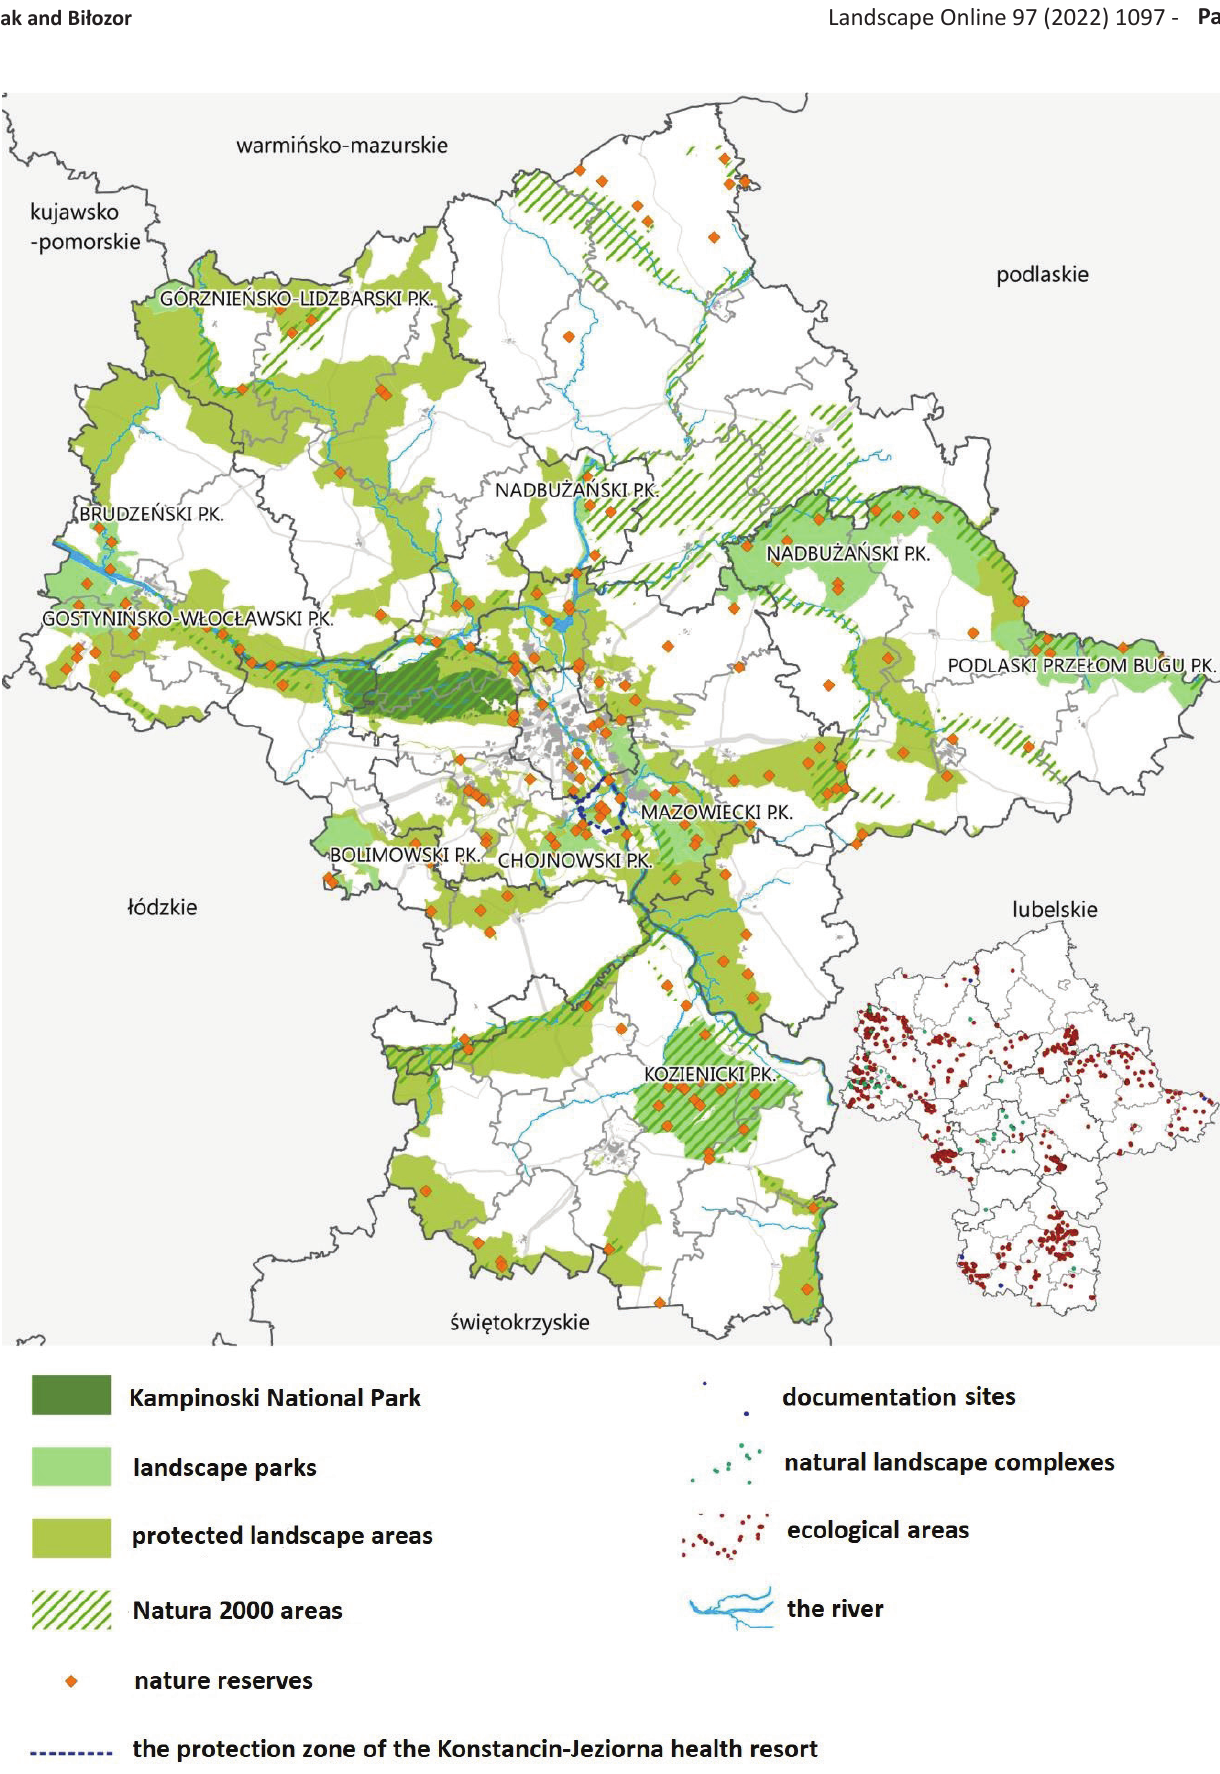
Figure 2. Natural environment resources (Spatial development plan 10 for the mazowieckie voivodeship